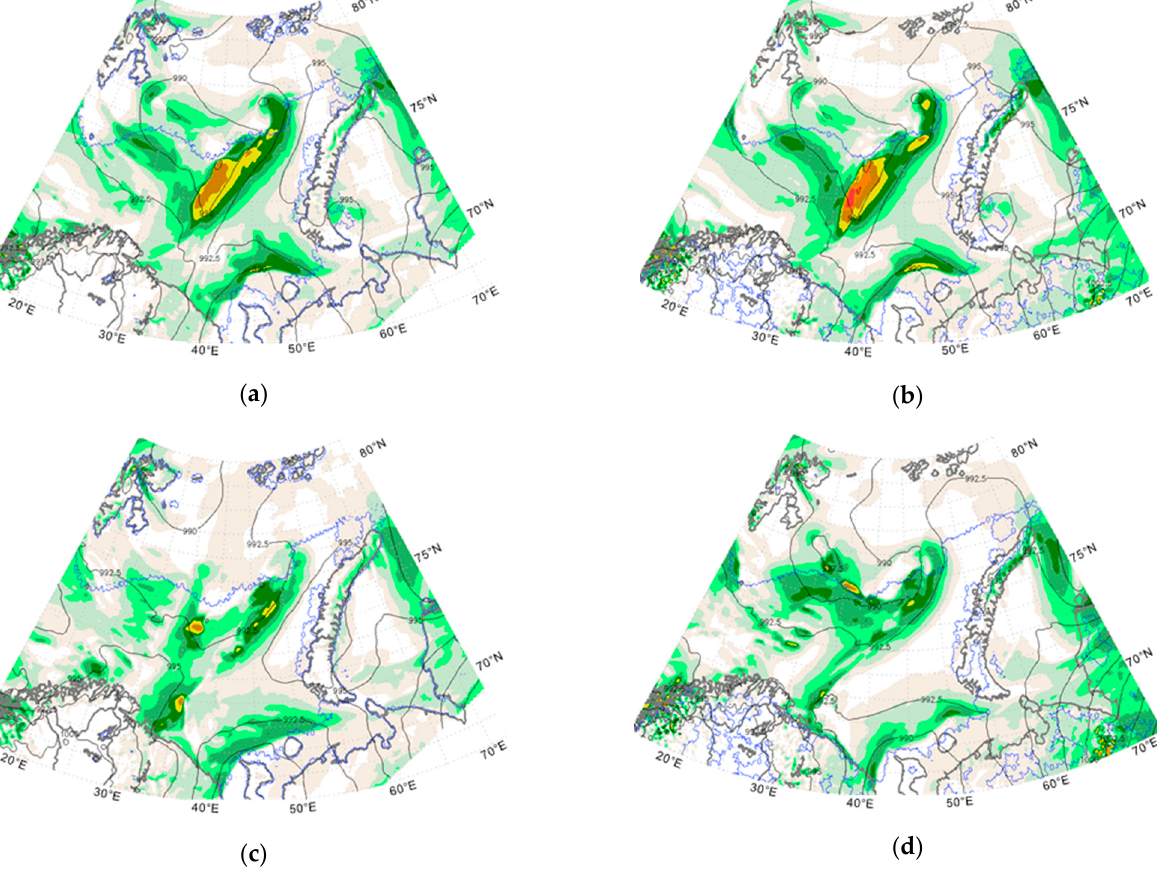
Figure A2. COSMO ‐ CLM ‐ A6.6 (left) and ICON ‐ A6.5 (right) comparison for different lead ‐ times: wind gusts and sea level pressure. Base time 00:00 UTC 26 February 2020 with lead time 06 h ( a , b ) and 00:00 UTC 25 February 2020 with lead time 30 h ( c , d ). Valid time 06:00 26 February 2020.